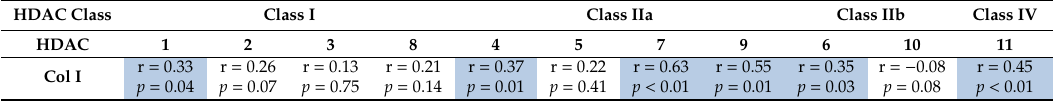
Table 1. Correlation of HDAC mRNA vs. collagen I (alpha 1) (Col I) in non-tumorous human liver tissues.